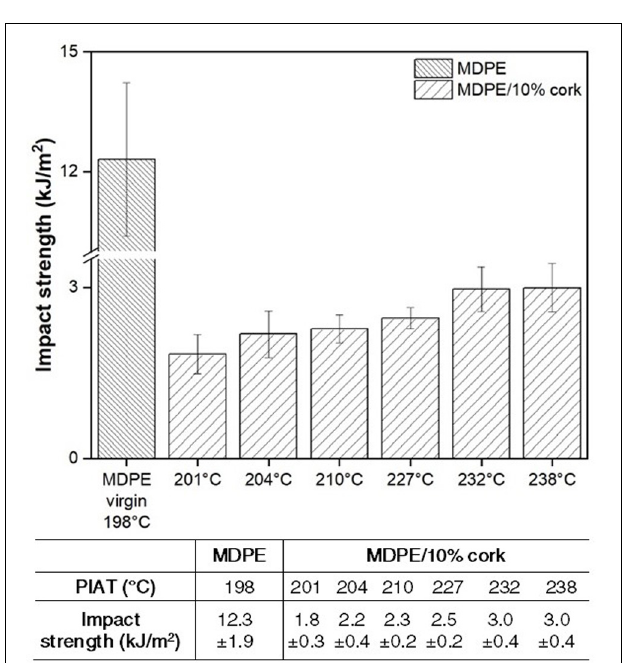
FIGURE 9 | Effect of PIAT on the impact strength of MDPE and MDPE/10 wt% cork